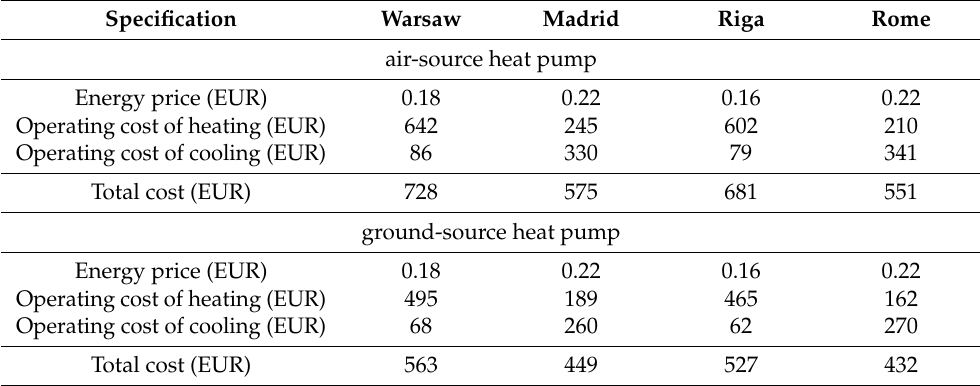
Table 4. Estimated operating costs of heat pumps. Specification